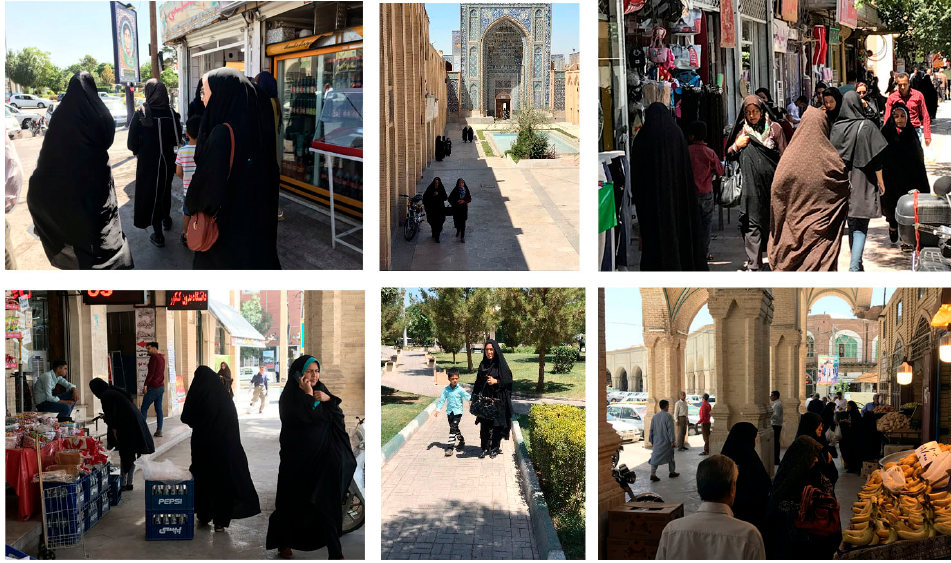
Figure 7. The behaviors in urban public spaces in traditional neighborhoods. (Source author).